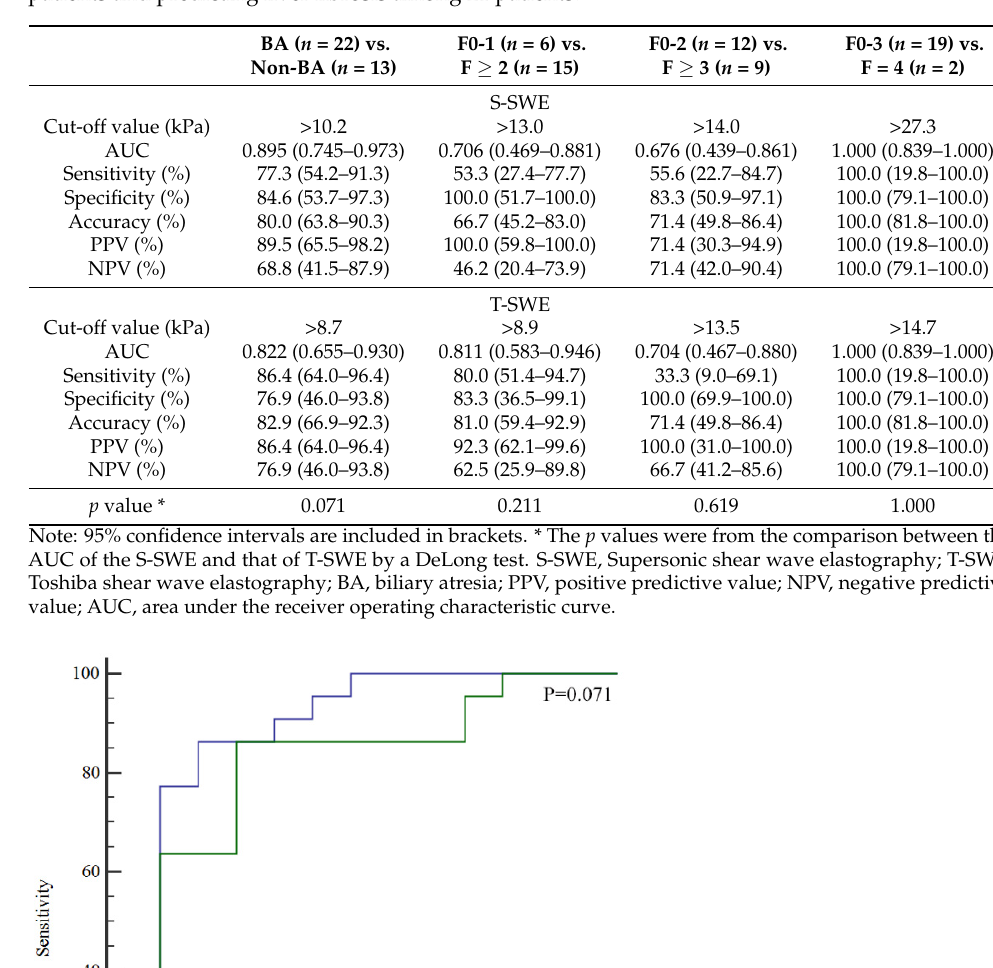
Table 2. Diagnostic performances of S-SWE and T-SWE in identifying biliary atresia among 35 pa- tients and predicting liver fibrosis among 21 patients.